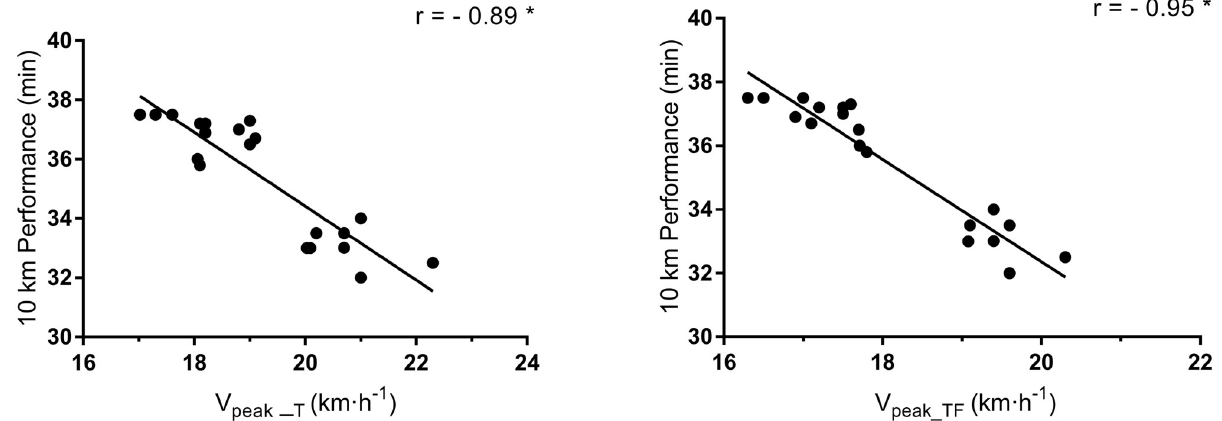
Fig 2. Correlation between both V peak values with 10-km running performance time. Note: V peak_TF , Peak running velocity on the track field; V peak_T , Peak running velocity on the laboratory treadmill test. � P < 0.05.